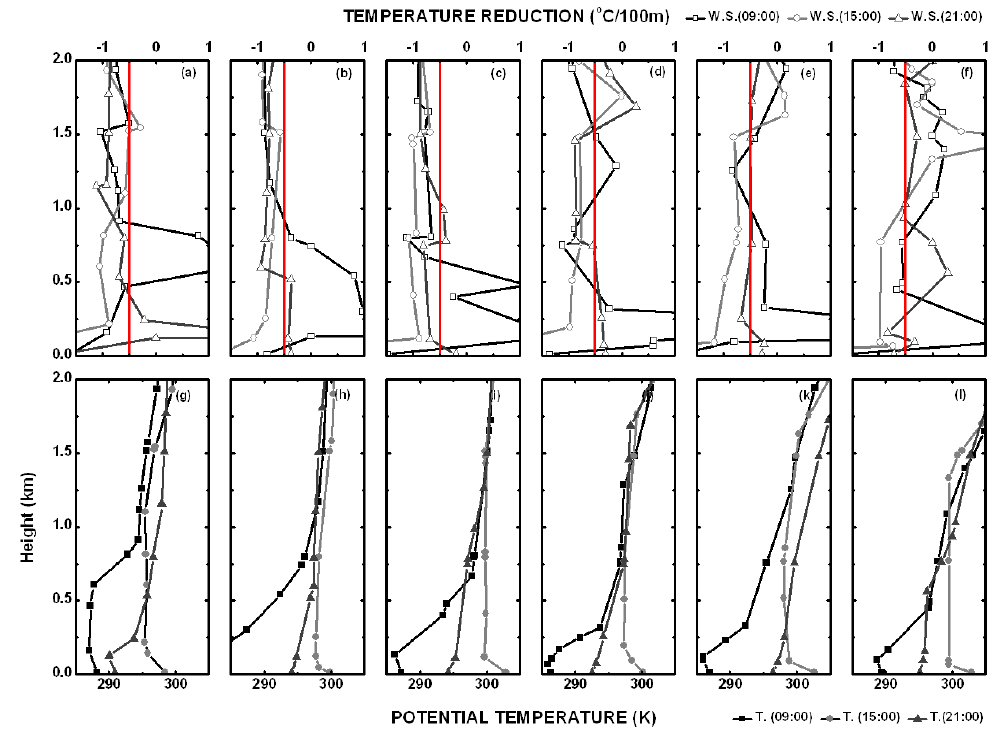
Fig. 9. Radiosonde data taken on 4 May (a, g) , 5 May (b, h) , 6 May (c, i) , 7 May (d, j) , 8 May (e, k) , and 9 May (f, l) . Temperature decrease observed on 09:00 (open square), 15:00LT (open circle) and 21:00LT (open triangle). Potential temperature observed on 09:00LT (closed square), 15:00LT (closed circle) and 21:00LT (closed